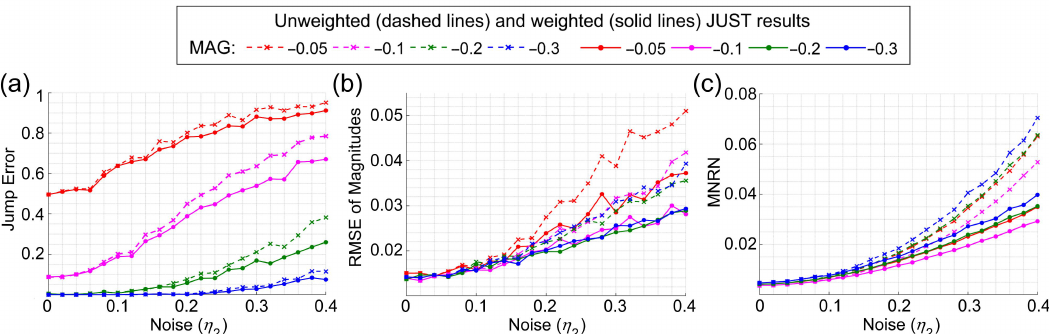
Figure 9. Same caption as Figure 8 but for collections of three-year-long time